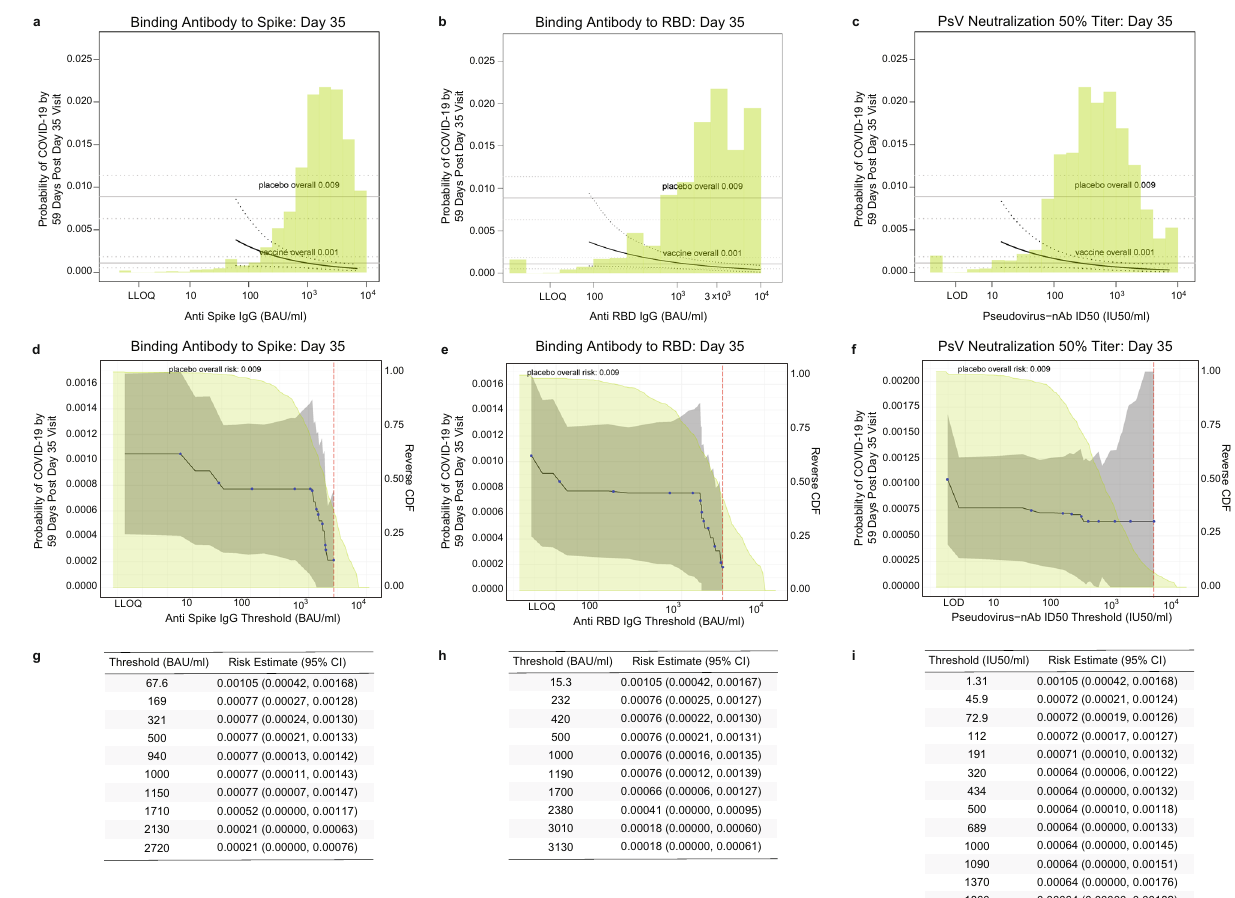
Fig.4|AnalysesofD35antibodymarkersasacorrelateofriskinbaselineSARS- CoV-2 negative per-protocol vaccine recipients (U.S. study sites). Baseline risk score-adjustedcumulativeincidenceofCOVID-19by59dayspostD35byD35 a anti- spikeIgG, b anti-RBD IgG, or c pseudovirus (PsV)-nAb ID50 titer,estimated using a marginalized Cox model. The dotted black lines indicate bootstrap pointwise 95% CIs.Theupperandlowerhorizontalgraylinesaretheoverallcumulativeincidence of COVID-19 from 7 to 59 days post D35 in placebo and vaccine recipients, respectively. Curves are plotted over the antibody marker range from the 2.5th percentile tothe97.5th percentile: 60.9 to6934BAU/mlforspikeIgG(where6934 is theULOQ),89.8to9801BAU/mlforRBDIgG(where9801istheULOQ),and14.2 to 7230IU50/ml for PsV-nAb ID50. Baseline risk score-adjusted cumulative inci- denceofCOVID-19by59dayspostD35byD35 d , g anti-spikeIgG, e , h anti-RBDIgG,